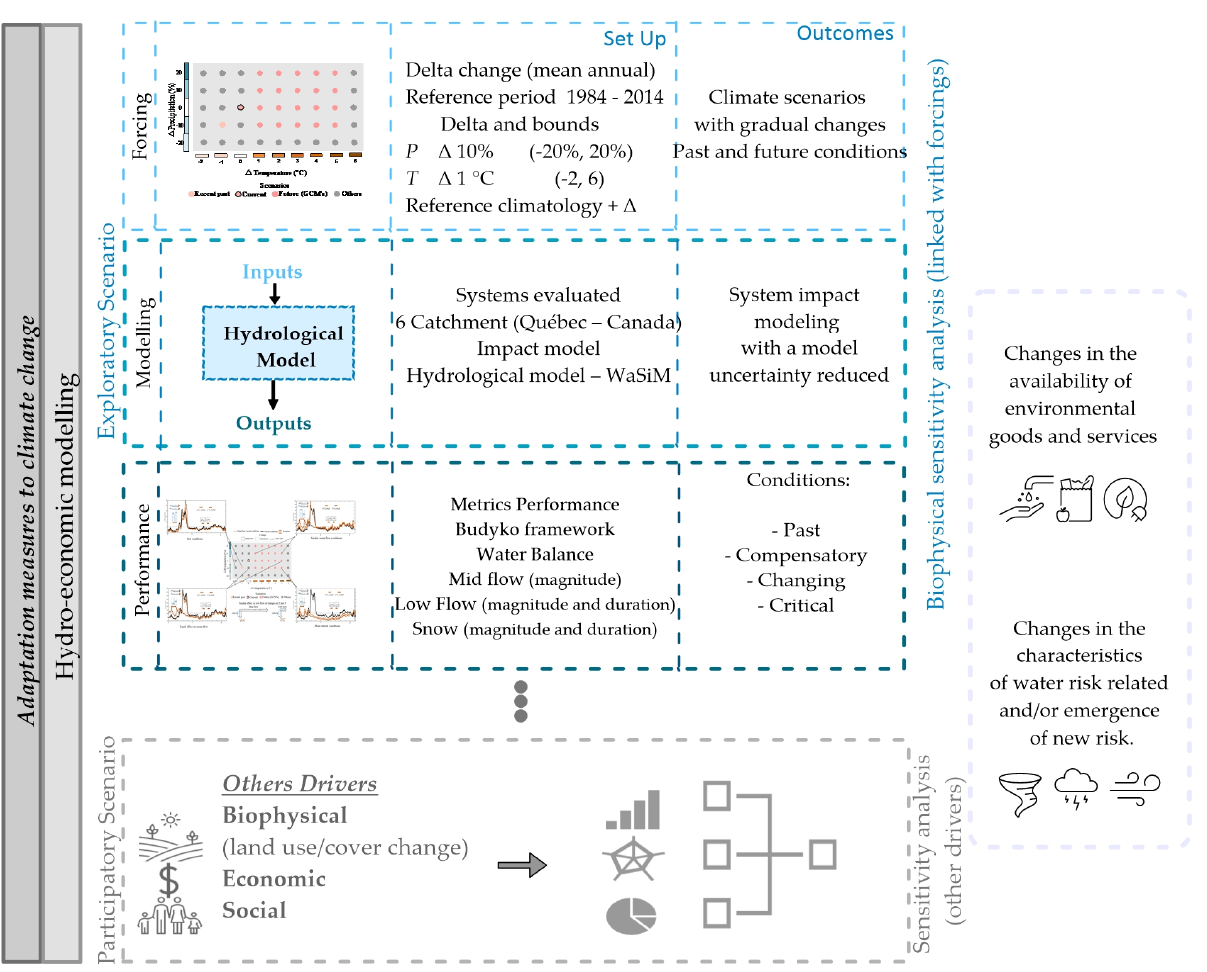
Figure 3. Modeling set up. The design of adaptation measures includes hydro–economic modeling composed of exploratory and participatory scenarios. In the former (in blue), three consecutive processes are shown in the rows: forcings, modeling, and performance, and in the middle and right–hand columns, respectively, the configuration and results obtained in this study. These three steps together constitute a sensitivity analysis of one of the biophysical components of the systems. In the lower part (in gray), the second scenarios are listed, which involve other biophysical components as well as the socioeconomic components that analyze the system’s vulnerability to other drivers. Finally, the central issues addressed by climate change adaptation are summarized on the right side (in purple).